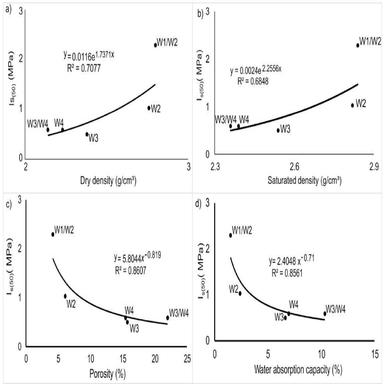
Correlations between IS(50) (perpendicular) and specific dry mass (a), specific saturated mass (b), porosity (c), and water absorption capacity (d).